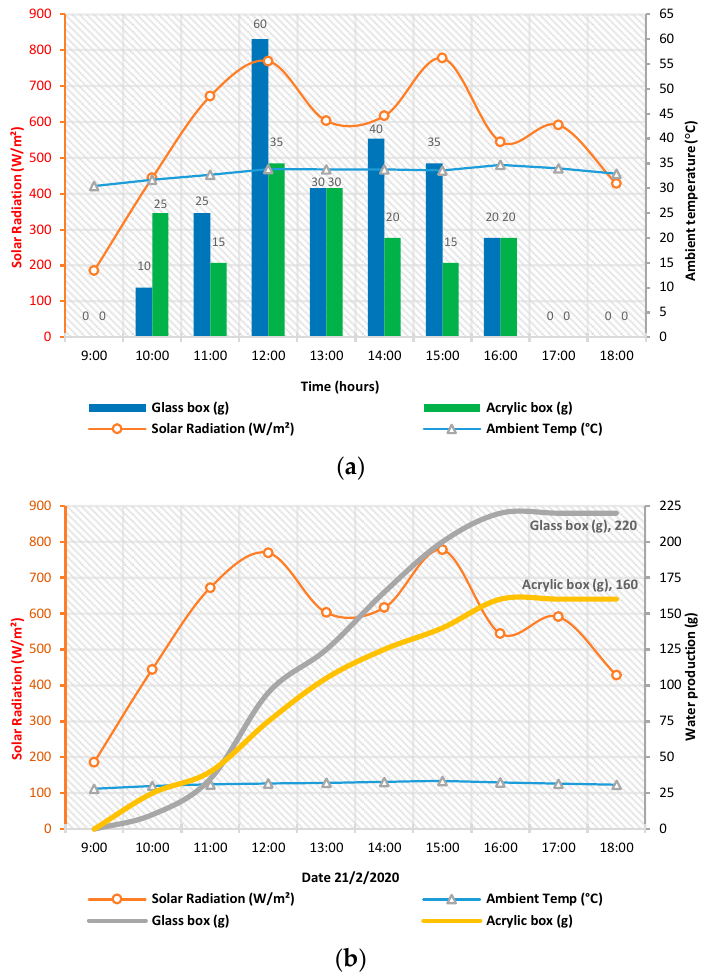
Figure 15. Variation of water production by glass and acrylic glazing systems on 21 February 2020: ( a ) hourly water produced and ( b ) accumulated water produced.